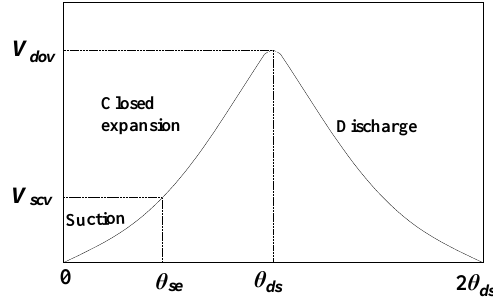
Figure 1. Simplified working process diagram of SSE.